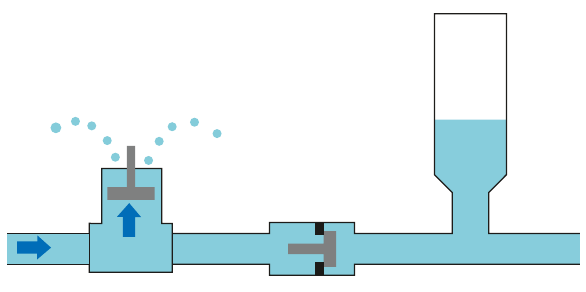
Figure 18: The automatic HRP working